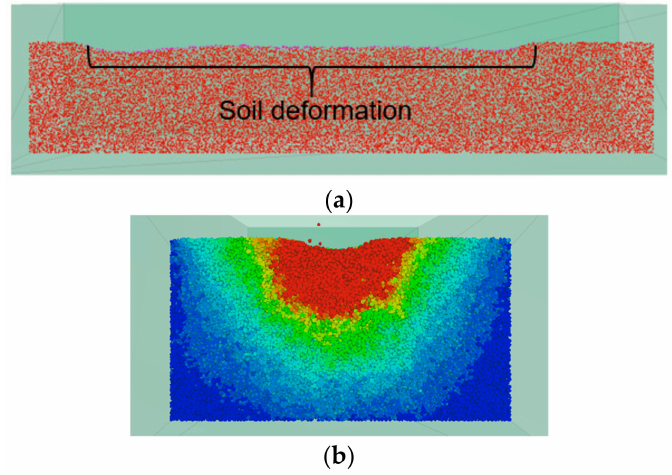
Figure 5. ( a ) Parallel cross-section of soil bin, indicating general sinkage; ( b ) soil cross-section perpendicular to the travel direction showing sinkage (displacement contour). Table 3. Relative mean errors of measured and simulated rolling resistance